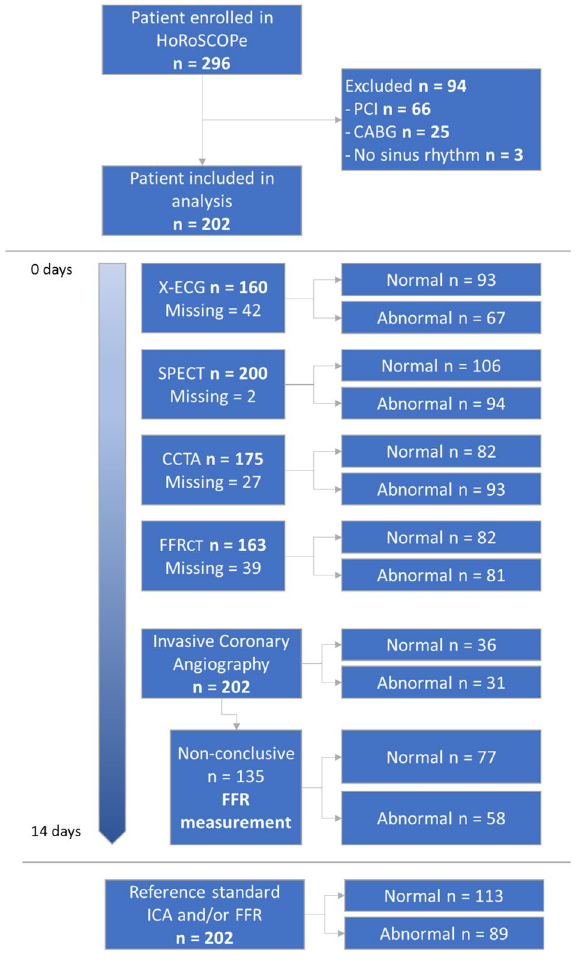
Figure 1. Study enrollment. CABG coronary artery bypass graft, CCTA coronary computed tomography angiography, ICA invasive coronary angiography, FFR fractional flow reserve, CT‑FFR computed tomography fractional flow reserve, PCI percutaneous coronary intervention, SPECT single photon emission computed tomography, X‑ECG exercise